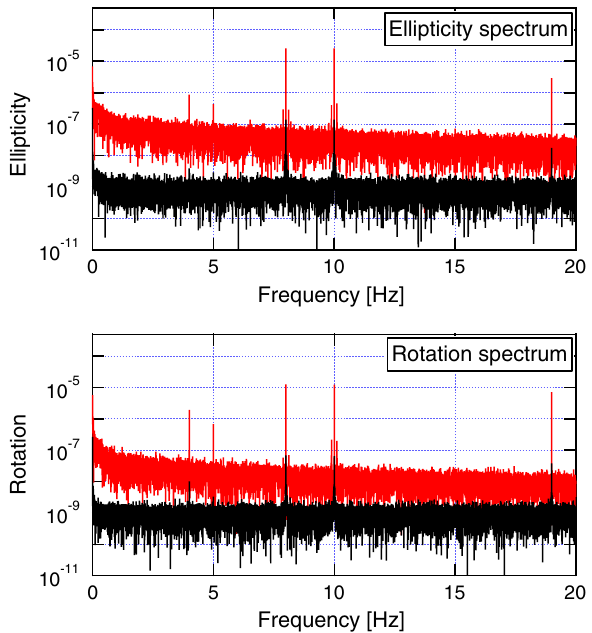
Fig. 6 Ellipticity (top panel) and rotation (bottom panel) raw spectra for an integration time of t = 512 s for F 1 = 6 . 88 × 10 5 . In red is the FFT of the in-phase component whereas in black is the quadrature component. A zoom from 0 Hz to 20 Hz is shown to better appreciate the peaks at 2 ν α = 8 Hz, 2 ν β = 10 Hz, of equal amplitudes, and at ν F = 19 Hz. Peaks at ν α and ν β are also present due to a slight non orthogonality between the beam and the magnetic field direction generating a time dependent Faraday rotation in the Argon